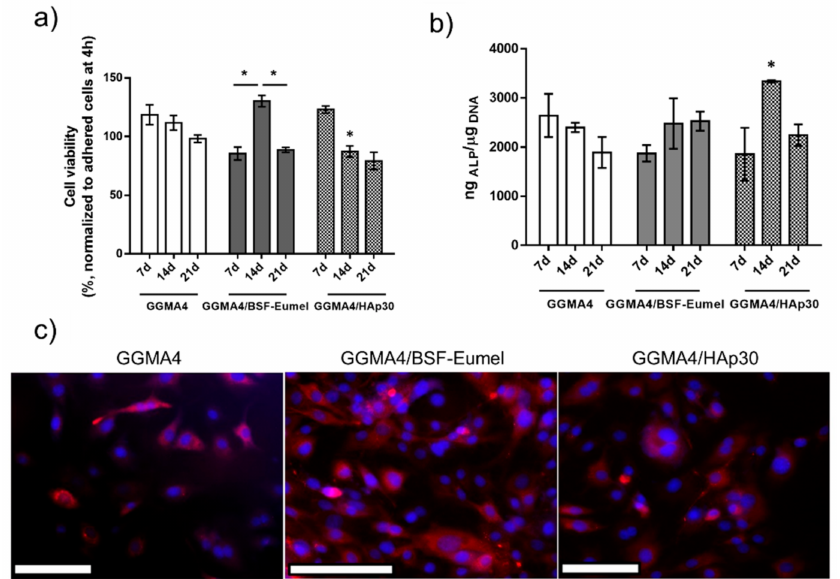
Figure 6. ( a ) Cell viability of 7F2 osteoblasts seeded onto GGMA4, GGMA4/BSF-Eumel and GGMA4/HAp30 scaffolds at 7, 14 and 21 days of cell culture normalized to adhered cells 4 h post-seeding (data are reported as mean value of cell viability percentage ± S.E.M., n = 4, * p < 0.05 vs. GGMA4). ( b ) ALP activity (expressed as ng ALP / µ g DNA ) for GGMA4, GGMA4/BSF-Eumel and GGMA4/HAp30 at 7, 14 and 21 days (data are reported as mean value ± S.E.M., n = 4, * p < 0.05 vs. GGMA4. ( c ) Representative fluorescent images acquired of 7F2 cells seeded on the different structures, at 24 h after cell seeding. (Scale bar: 500 µ